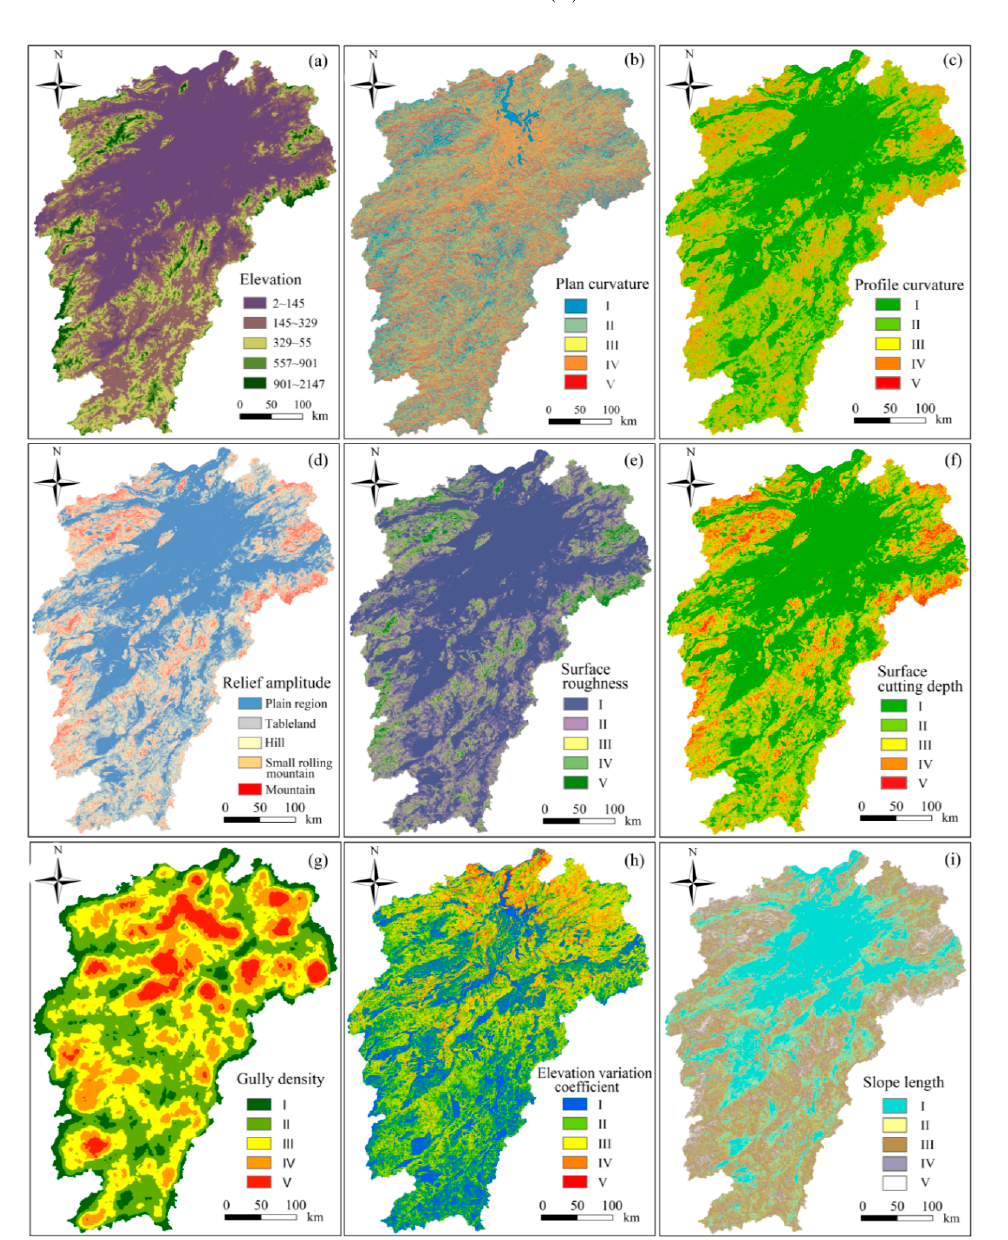
Figure 2. Terrain factors: elevation ( a ), plan curvature ( b ), profile curvature ( c ), relief amplitude ( d ), surface roughness ( e ), surface cutting depth ( f ), gully density ( g ), elevation variation coefficient ( h ), slope length ( i ).